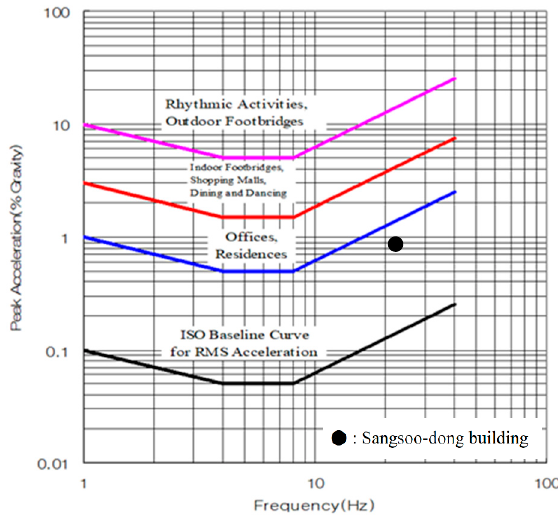
Figure 20. Vibration evaluation curve based on the ISO 2631-2 floor vibration standard [29]. Table 12. Natural frequency and maximum acceleration for the two buildings.